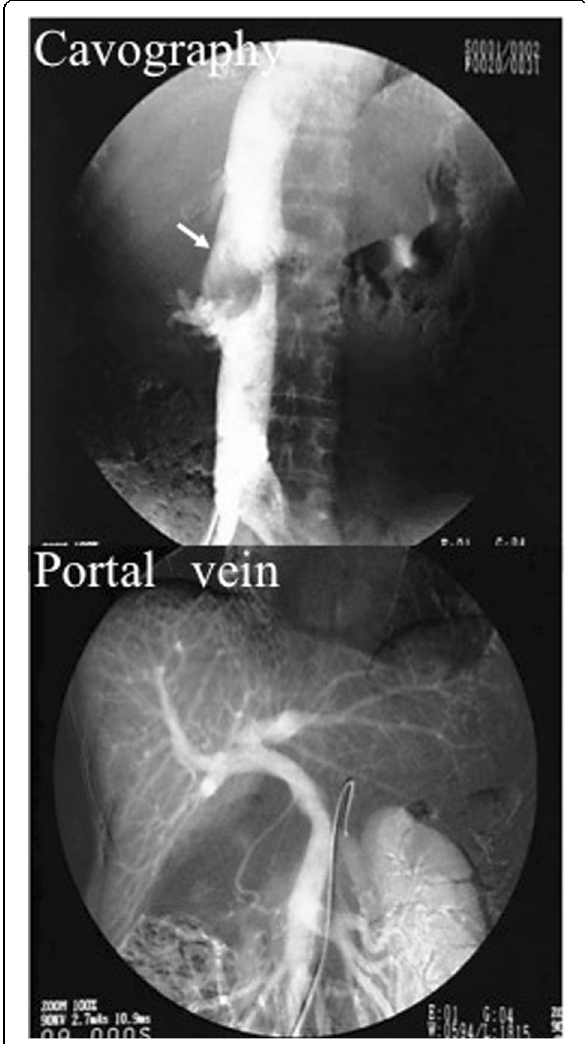
Fig. 4 Abdominal angiography. The arrow indicates the compression site by the tumor. An inferior vena cavogram showed partial compression of the IVC. Superior mesenteric arteriography showed displacement of the portal vein. IVC inferior vena